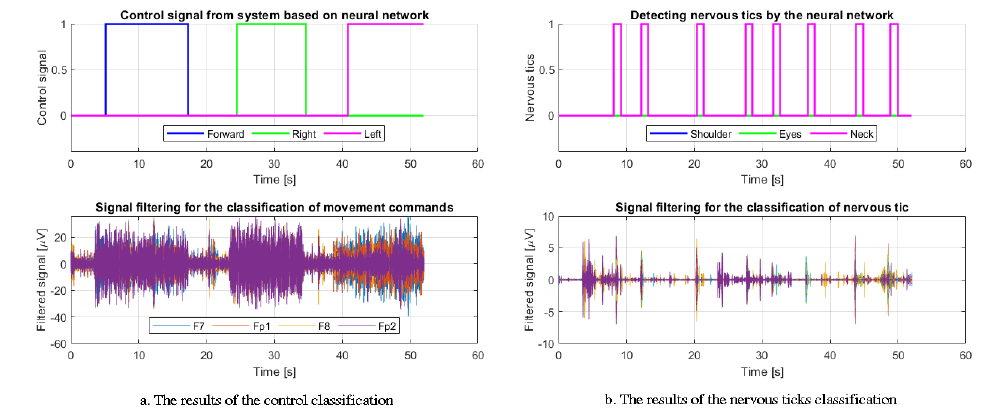
Figure 21. An example of the classification of movement commands and nervous tics—neck mus- cles tightening.